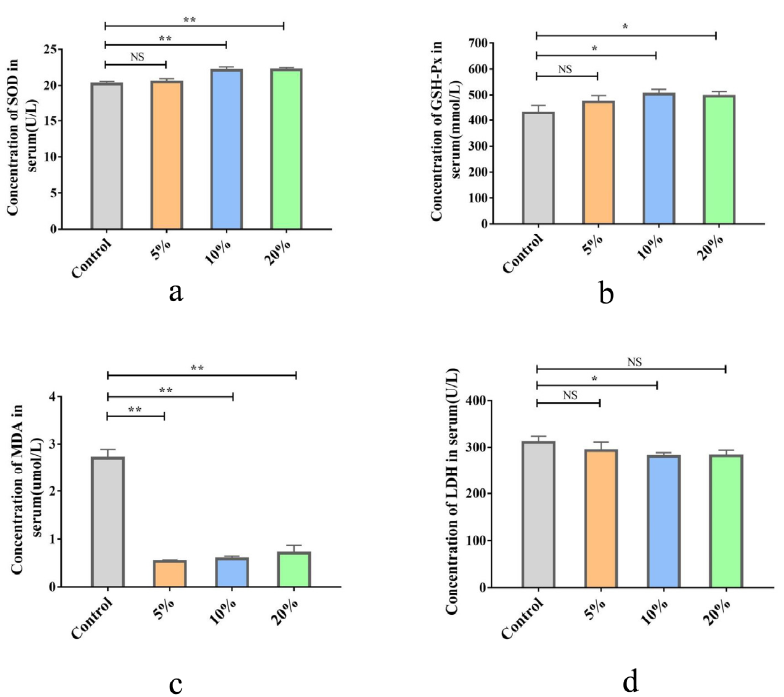
Figure 2. The effect of TWW on the antioxidant capacity in the serum of chickens. ( a ) Superoxide dismutase (SOD) activity. ( b ) Glutathione peroxidase (GSH-Px) activity. ( c ) Malondialdehyde (MDA) content. ( d ) Lactic dehydrogenase (LDH) activity. Values presented as means ± SEM. * p < 0.05, ** p < 0.01, compared with the control group. NS: no significance between the indicated groups.